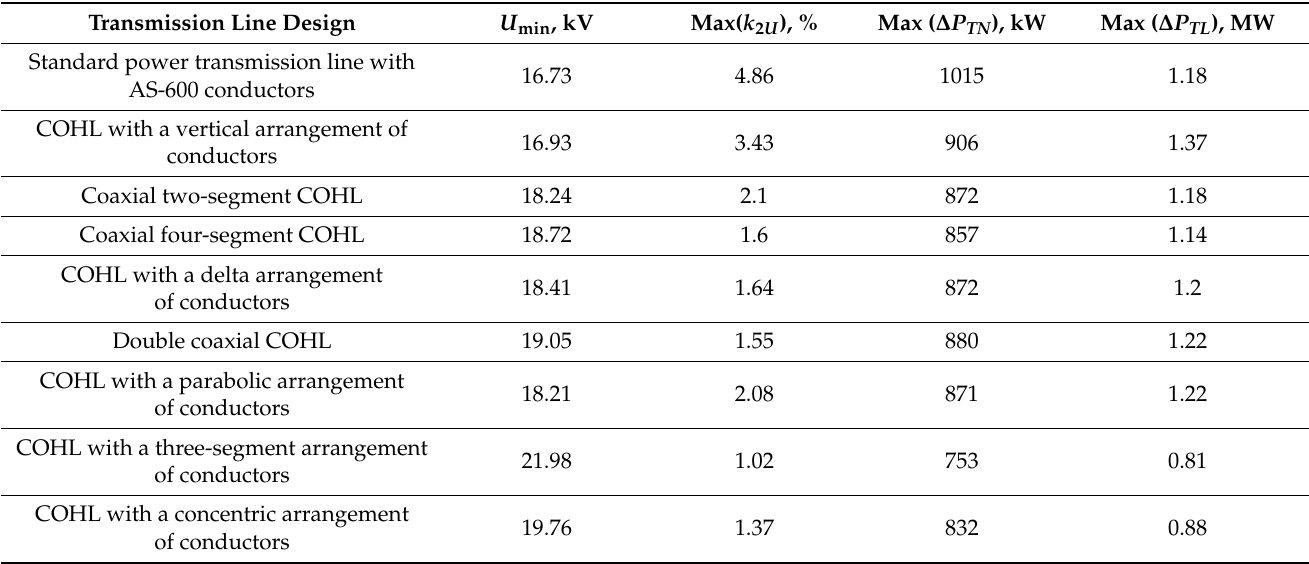
Table 1. Extreme values of parameters.